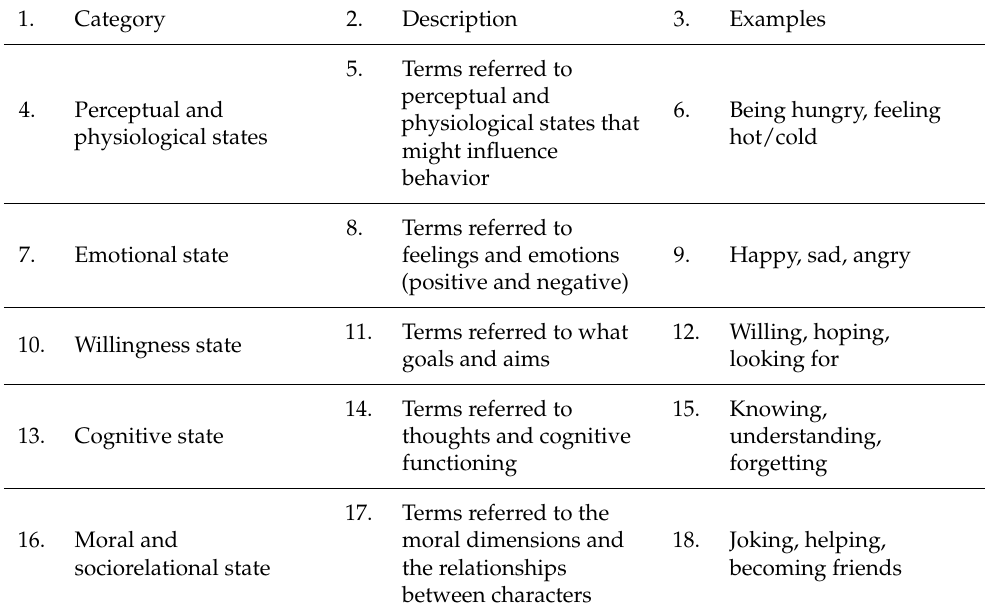
Table A1. Description of the coding system for mental state talk (adapted from Bretherton and Beeghly,